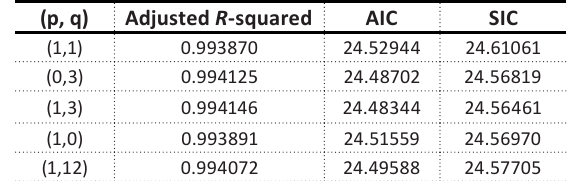
Table 1. Test results for ARMA ( p , q )